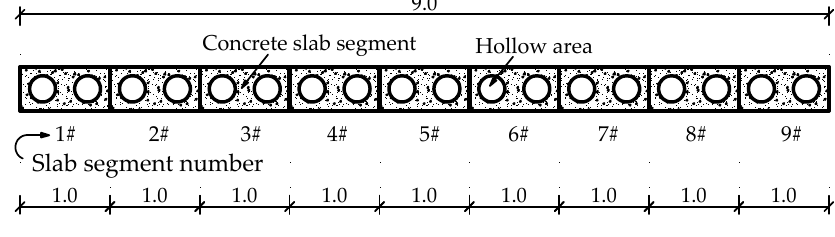
Figure 6. Cross ‐ section for the case bridge (unit: m). Figure 6. Cross-section for the case bridge (unit: